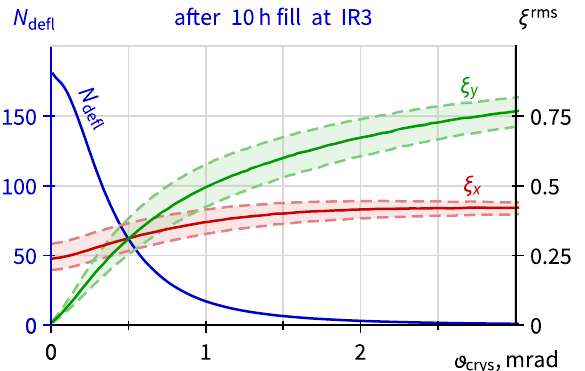
after 10 hour LHC fill as functions of initial crystal orientation ϑ crys . (Left) and (right) for configurations at IR3 and IR8,